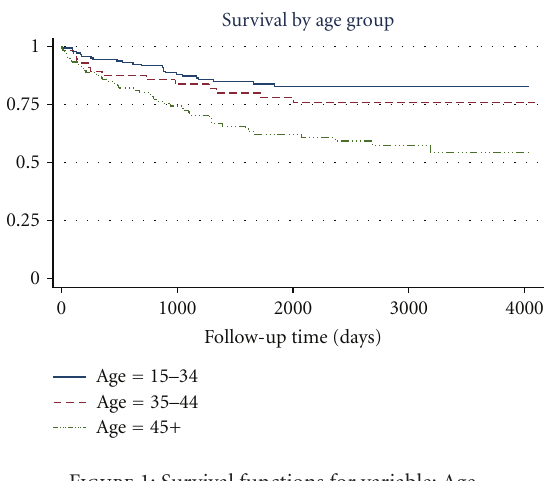
Figure 1: Survival functions for variable: Age.